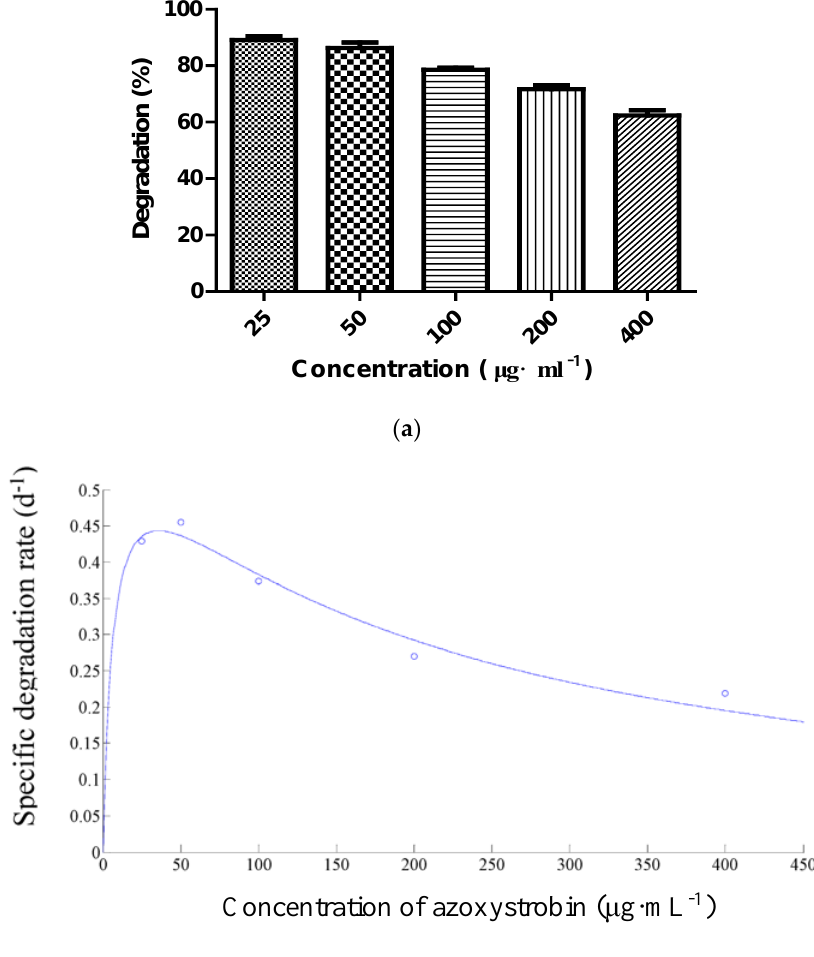
Figure 5. ( a ) Degradation of azoxystrobin at different concentrations; ( b ) Relationship between initial azoxystrobin concentration and specific degradation rate ( q ) of strain SH14. The dot in ( b ) refers to the specific degradation rate (d − 1 ) at the concentration of 25, 50, 100, 200, and 400 µ g · mL − 1 of azoxystrobin, respectively.